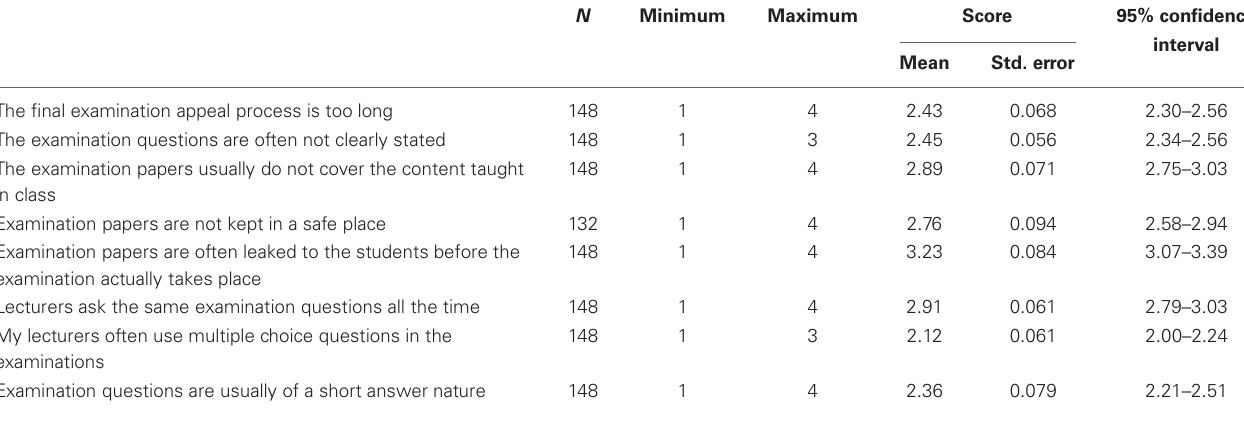
Table 5 | Conduct of the final examination and the appeal